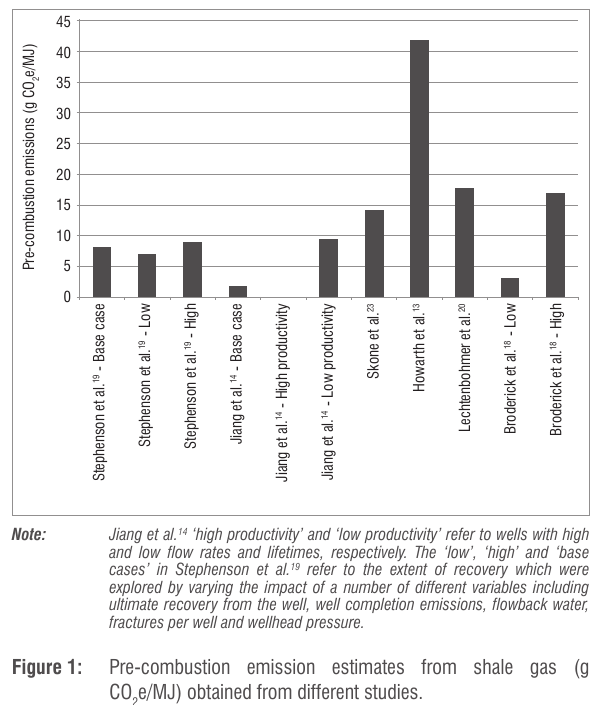
Figure 1: Pre-combustion emission estimates from shale gas (g CO e/MJ) obtained from different studies. 2